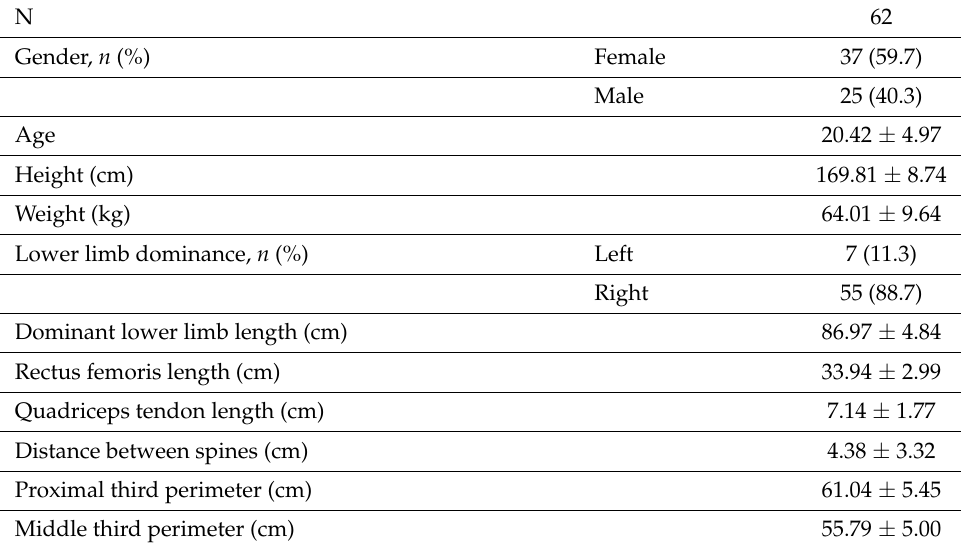
Table 1. Clinical and demographic characteristics of the